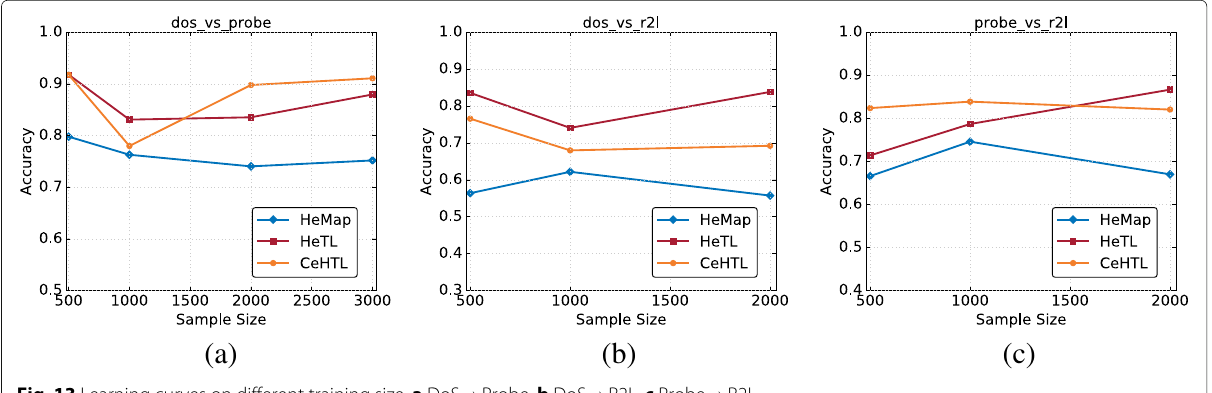
Fig. 13 Learning curves on different training size. a DoS → Probe. b DoS → R2L. c Probe →